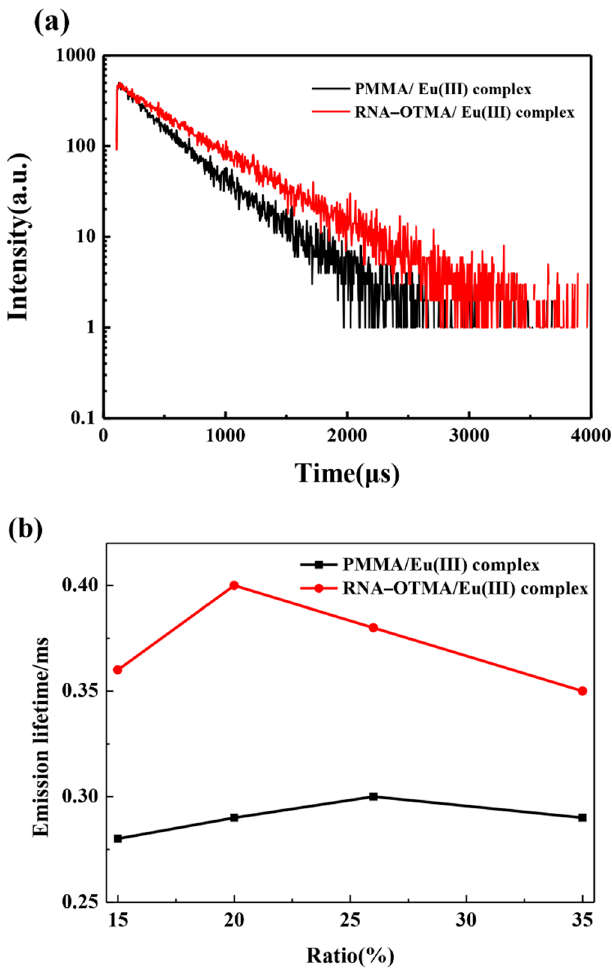
Figure 10. ( a ) Fluorescence lifetime of the films at [RNA–OTMA/PMMA]: [Eu (TTA) 3 (H 2 O) 2 ] = 4:1 ( b ) Fluorescence lifetimes of RNA–OTMA/Eu complex films and PMMA/Eu complex films at different Eu (III) complex contents.